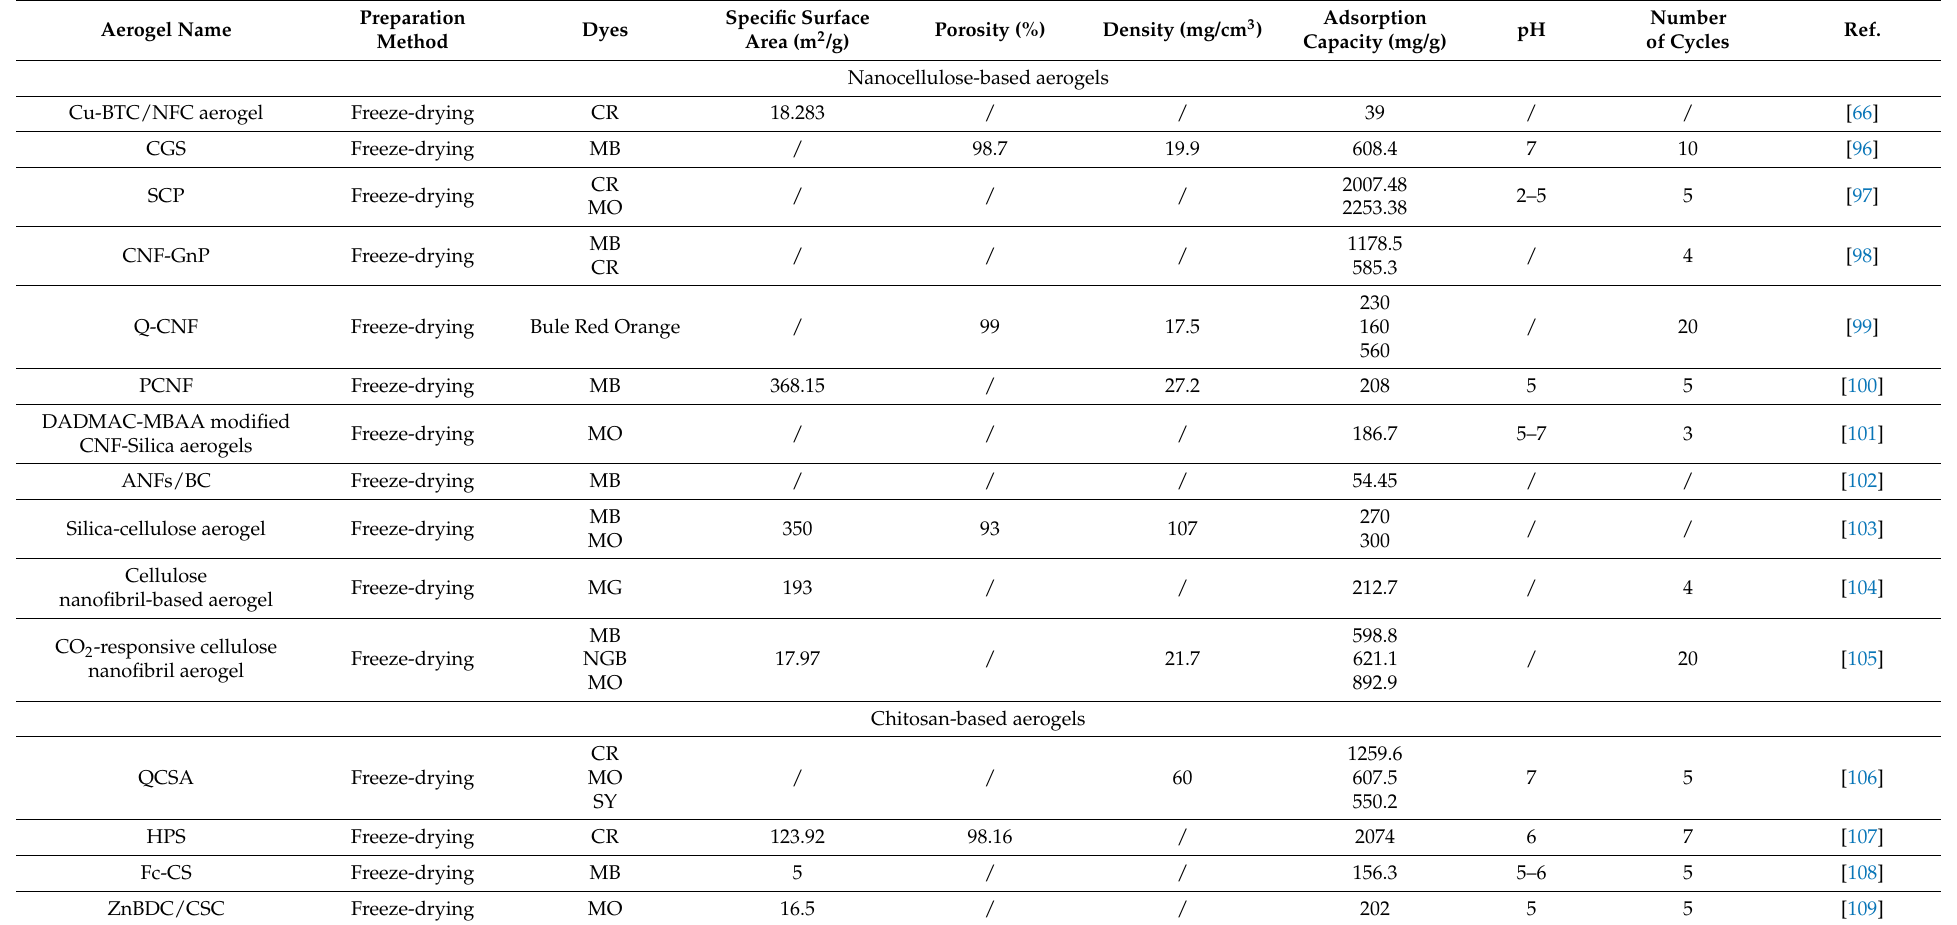
Table 4. Performance of nanocellulose-based aerogels in dye removal compared with chitosan-based aerogels. QCSA: quaternized chitosan aerogel; SY: sunset yellow dyes; HPS: chitin/chitosan-based aerogel; ZnBDC/CSC: Zn-MOF/citrate-crosslinked